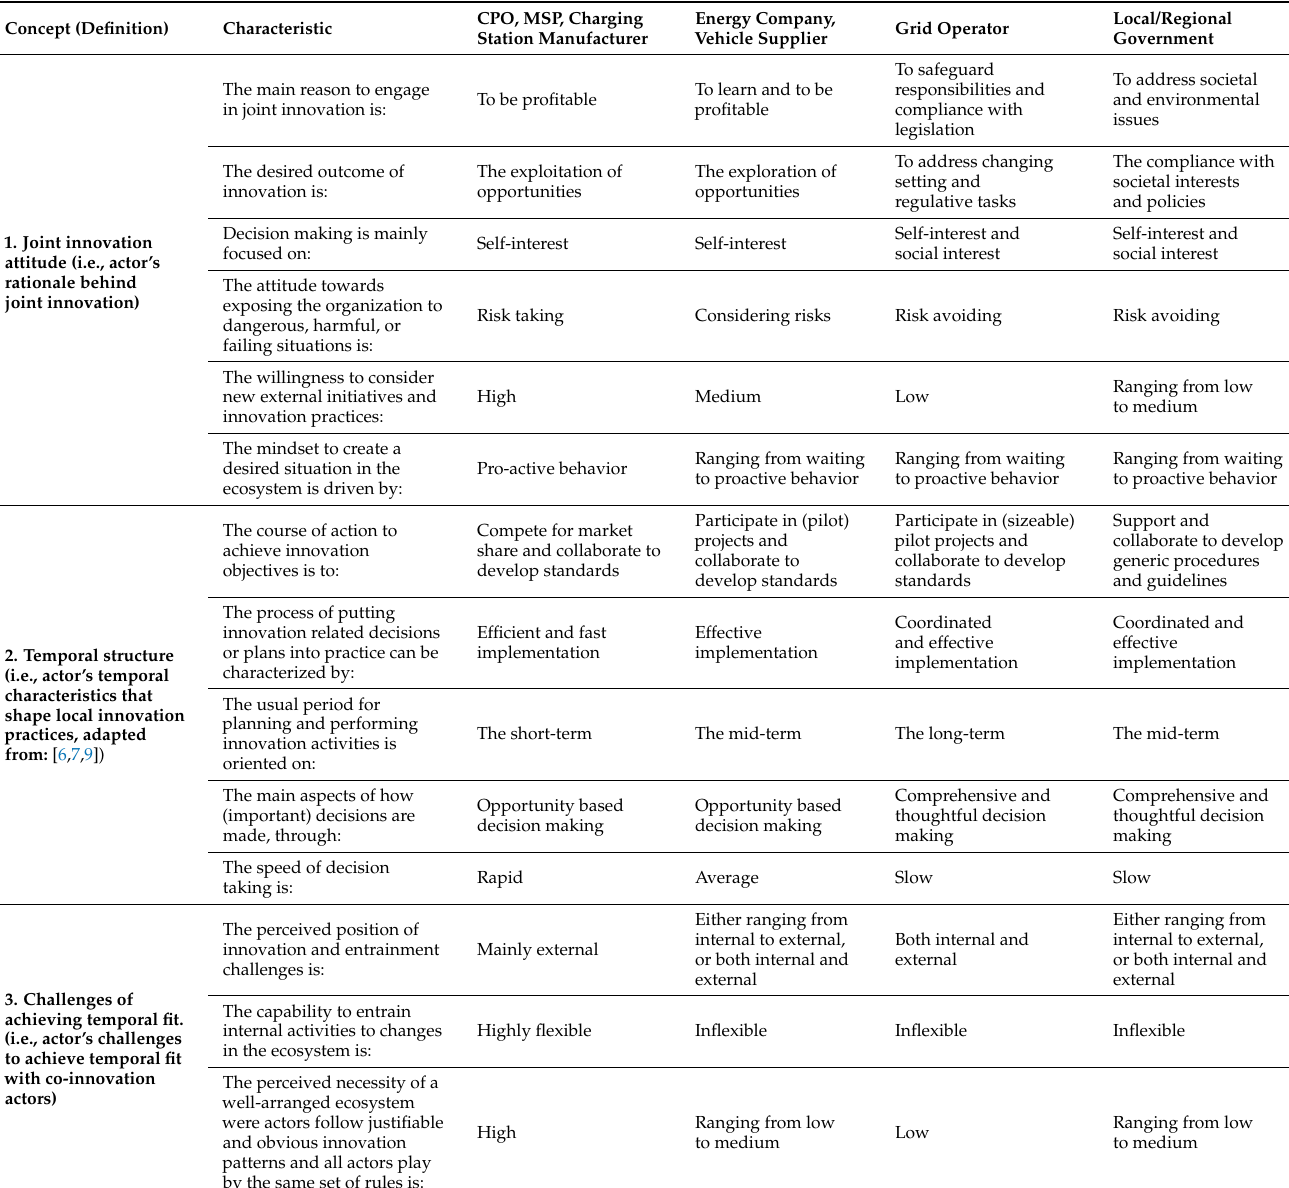
Table 2. Concepts and characteristic that drive temporal work in innovation